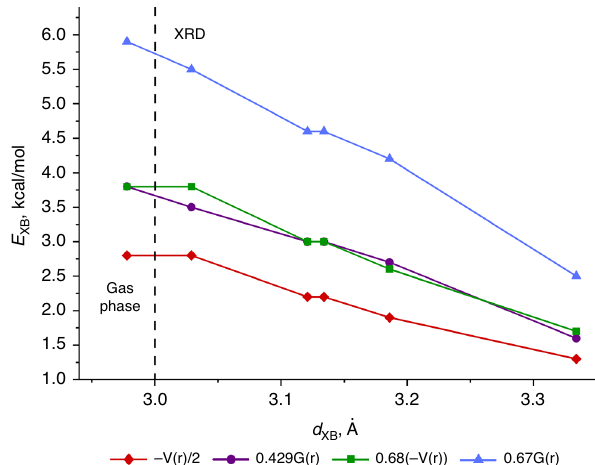
Fig. 4 The correlation between I···C distances and XB energies in the adducts. The correlation between I···C distances ( d XB , Å) in the experimental XRD and optimized gas phase structures of studied adducts and the XB energies (kcal · mol – 1 ) de fi ned by four different approaches: E XB = – V(r)/2 50 (red diamonds), 0.429G(r) 51 (purple circles), 0.68( – V(r)) 52 (green squares), 0.67G(r) 52 (blue triangles). Data are taken from Table 3.